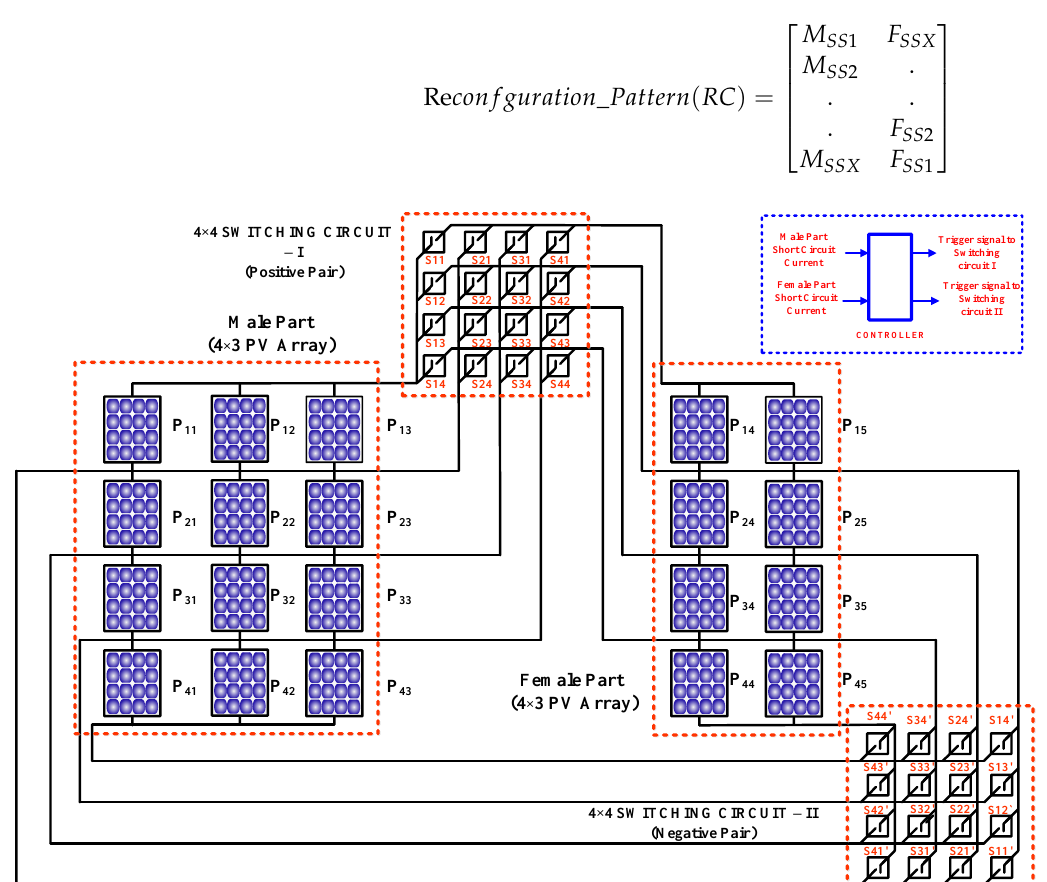
Figure 2. Proposed 4 × 5 TCT array with twenty panels.